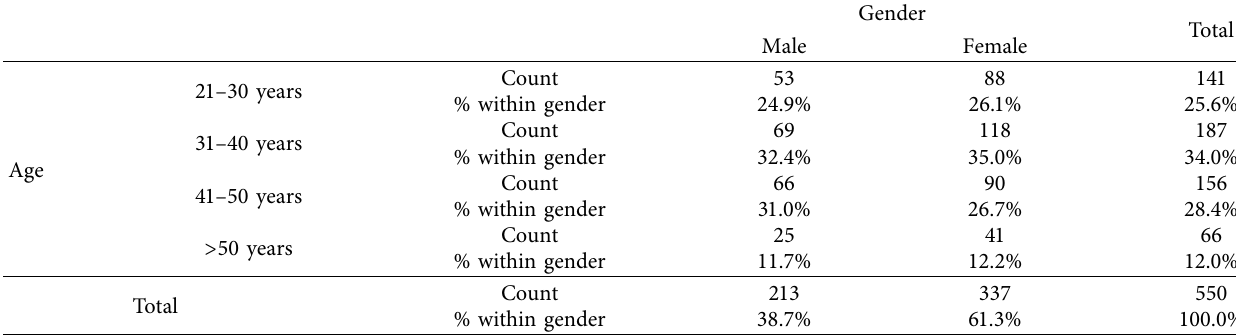
Table 1: Age and genderwise distribution of the study